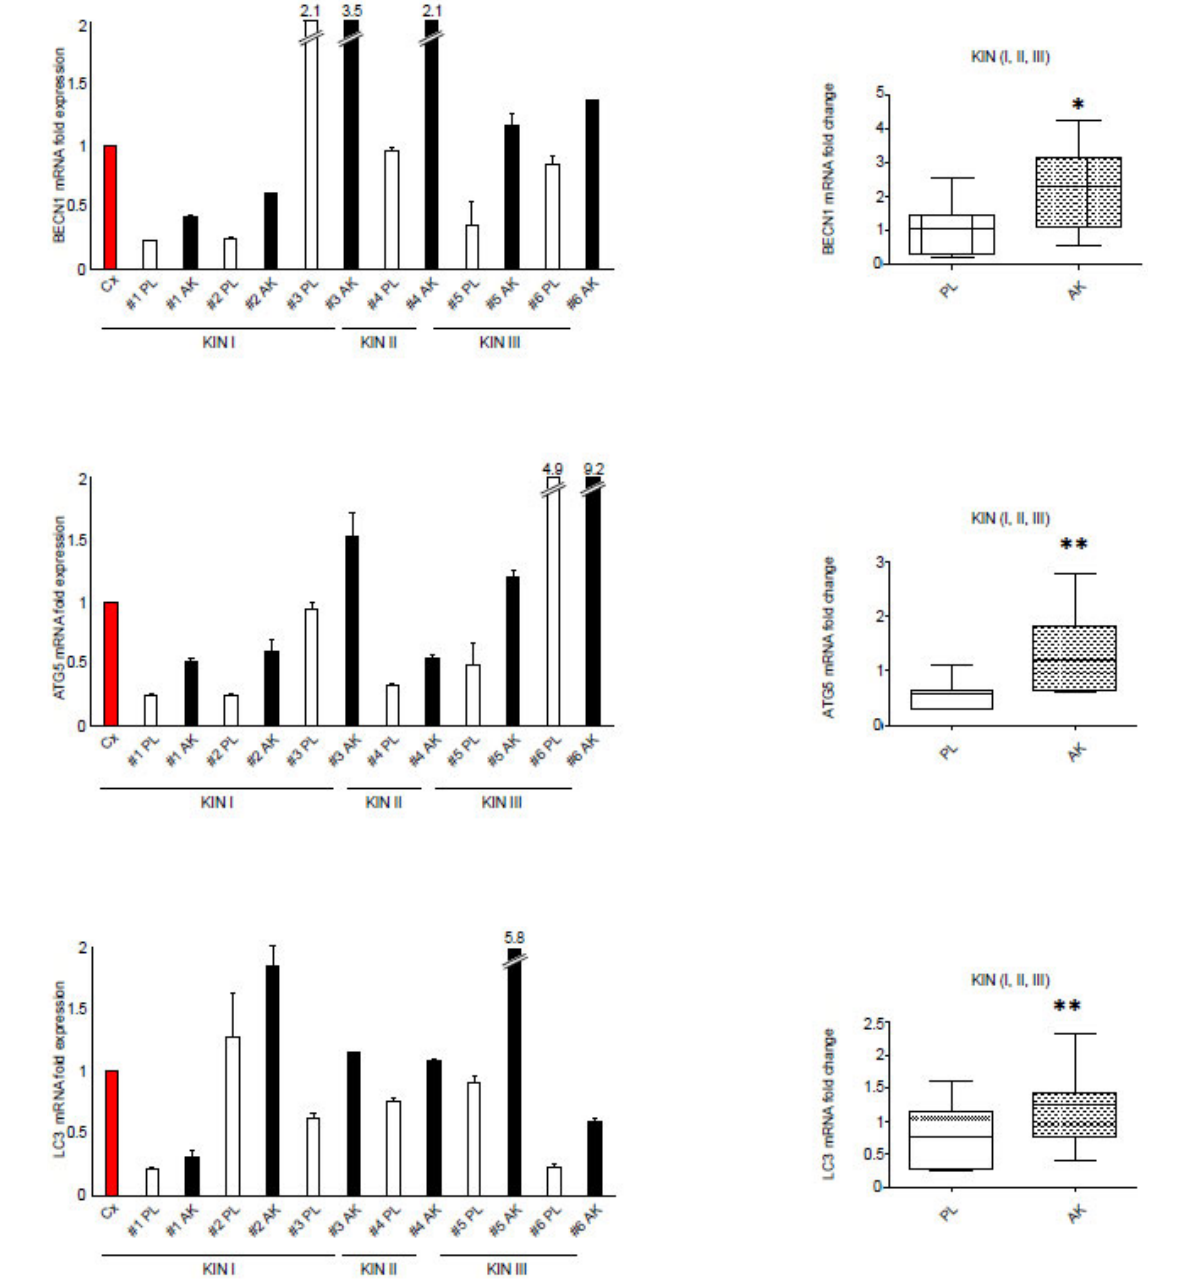
Figure 3. Expression of autophagic genes in the dermal portion of KIN I, KIN II, and KIN III samples. BECN1, ATG5, and LC3 mRNA levels were evaluated by real-time RT-PCR in KIN I, KIN II, and KIN III samples (PL—perilesional samples, white bars; AK—lesional samples, black bars) and normalized with respect to the mean of all the perilesional values (Cx, red bar) as reported in the graph. Results are expressed as mean ± SD. Statistical analysis of relative expression rates of KIN I + KIN II + KIN III AK versus KIN + KIN I + KIN III PL samples was performed using Wilcoxon rank-sum test, and significance levels were defined as p < 0.05. * p < 0.05; ** p < 0.01 versus the corresponding PL samples.